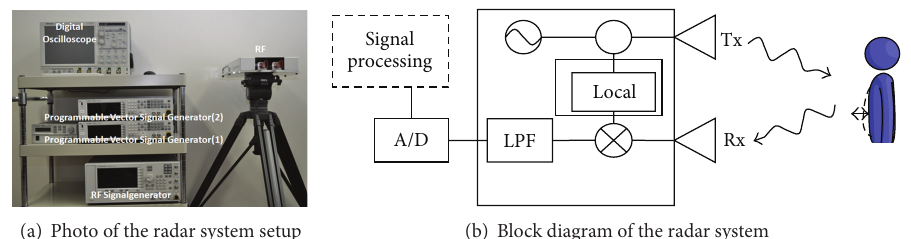
Figure 2: The proposed experimental radar